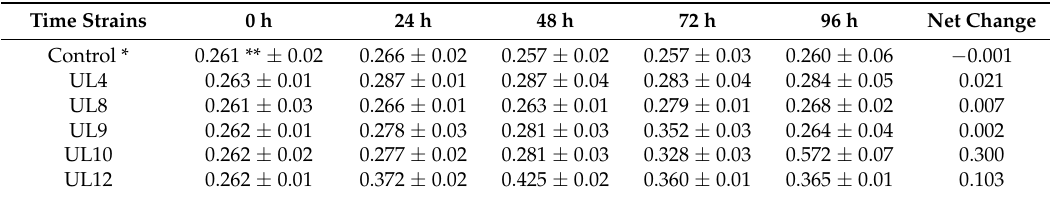
Figure 1. SDS-PAGE patterns of sarcoplasmic proteins present in the goat meat model system (MMS) inoculated with selected LAB strains, incubated at 30 ◦ C for96 h. ( a ) Non-inoculated control; UL10 isolate; ( b ) UL12; UL4 isolates; ( c ) UL8; UL9 isolates. Lanes 1–5: 0–96 h. M: molecular weight markers; kDa: kilodaltons. Table 5. Amino acid and small peptide content in MMS (goat meat model system) inoculated with selected LAB isolates and incubated at 30 ◦ C for 96